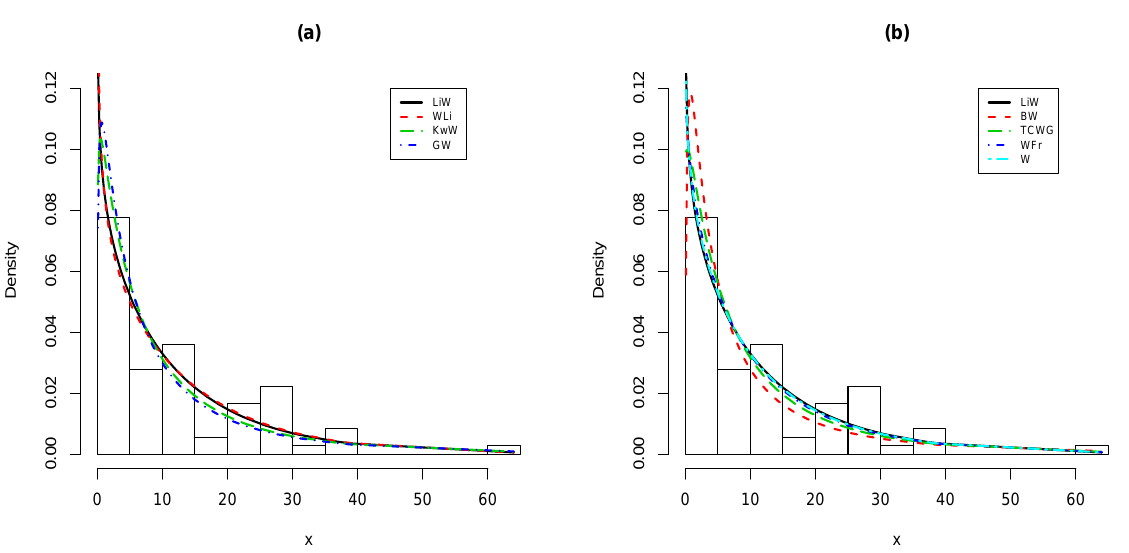
Figure 4 - The fitted densities for the: (a) LiW, WLi, KwW and GW models; (b) LiW, BW, TCWG, WFr and W models (data set